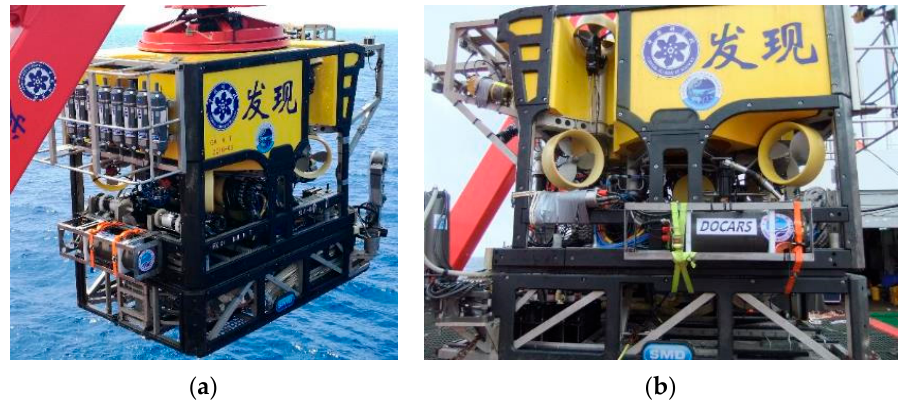
Figure 2. ROV installation solutions for DOCARS system. ( a ) Back mounting case. ( b ) Side mounting case.